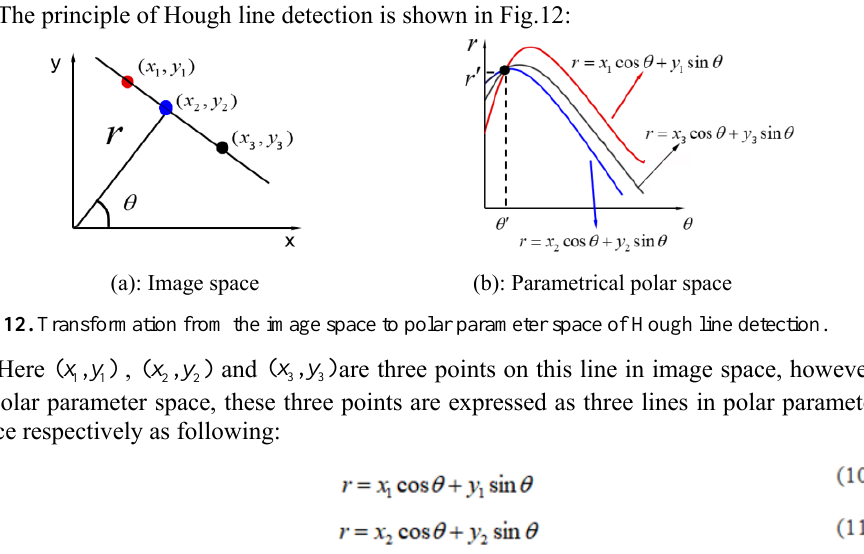
Fig. 11. A hole detected on metallic surface. ((a): a hole on metallic surface; (b): detection result of the hole in (a) with calculated diameter of 2.53mm; (c): a crack detected on metallic surface; (d): detection result of the crack in (c) with calculated gap of 0.25mm.).